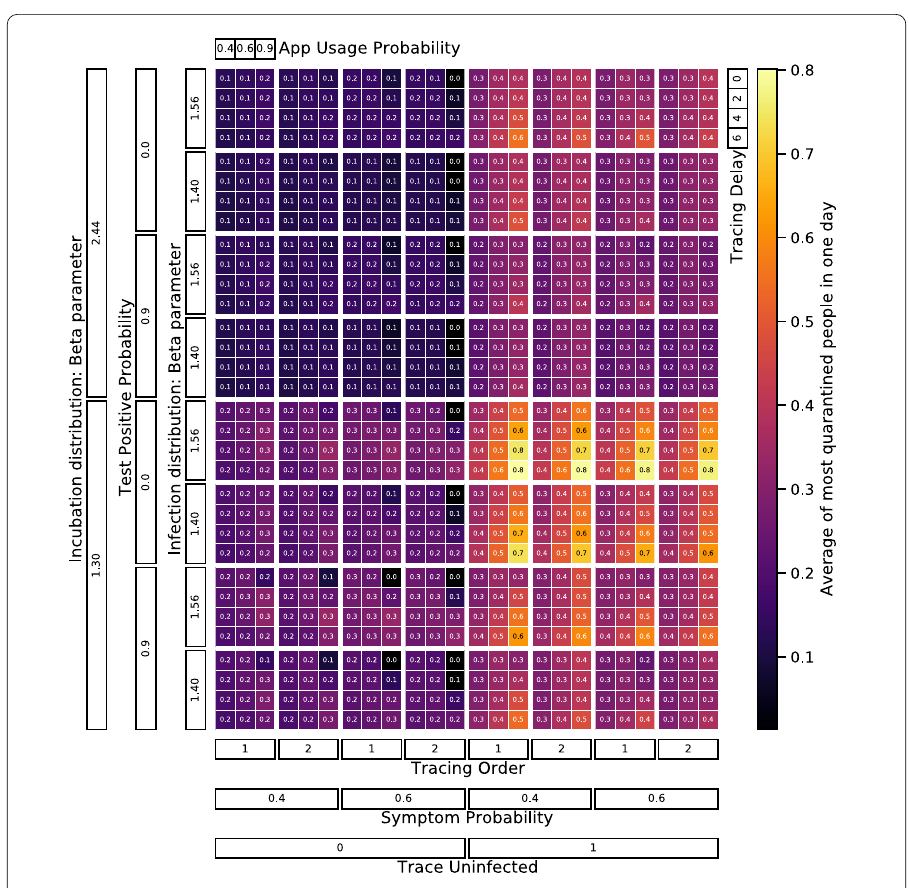
Figure 31 The fraction of the population that is quarantined on the day when most people are quarantined is shown for all combinations of parameters in the timing and delay parameter scan